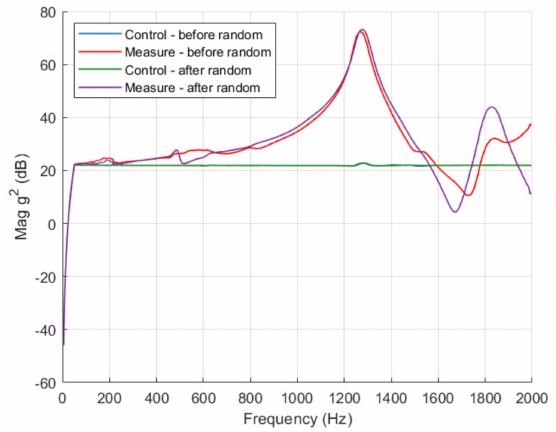
Figure 13. Resonances before and after tests on y axis, AISI 316 spindle.